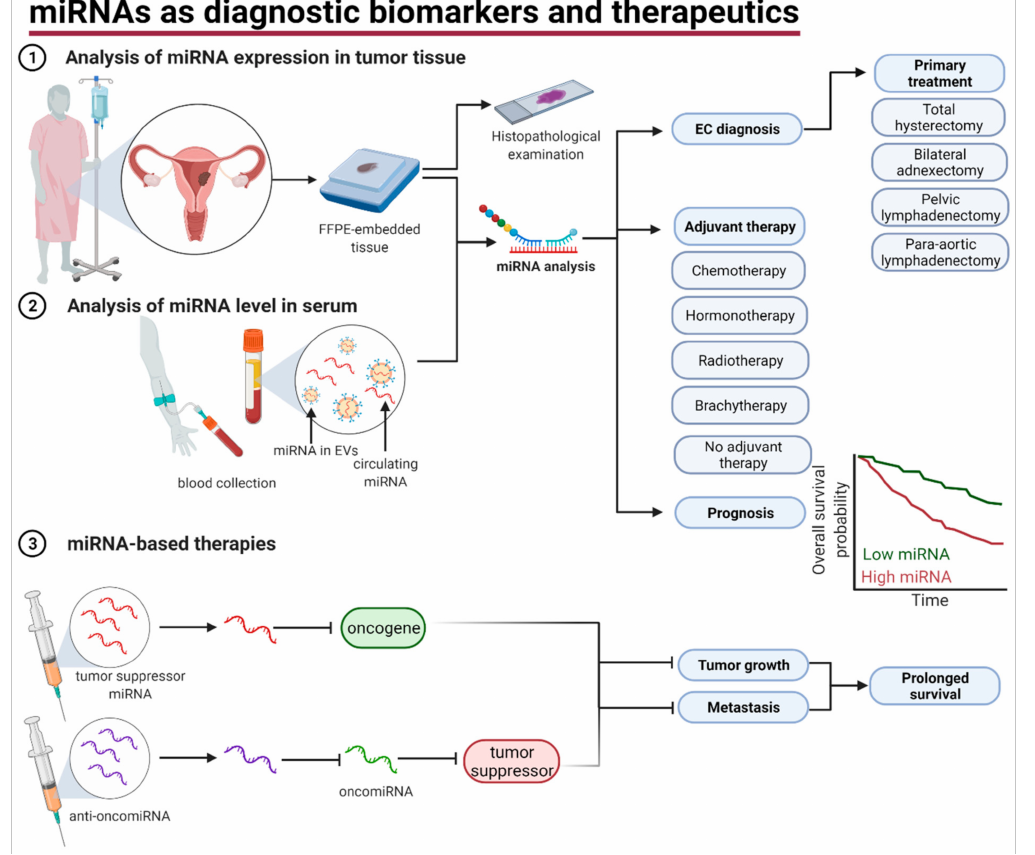
Figure 5. miRNAs as diagnostic biomarkers and therapeutics. miRNAs are promising biomarkers that can be analyzed either from tumor tissue (1) or from blood obtained from EC patients (2). miRNAs may support EC diagnosis and indicate primary and adjuvant treatment. Moreover, their expression is an important prognostic factor. miRNA-based therapies that include tumor suppressor miRNAs and anti-oncomiRNAs are currently tested in preclinical and clinical trials (3). EVs—extracellular vesicles, FFPE—formalin-fixed, paraffin-embedded. Figure was created using